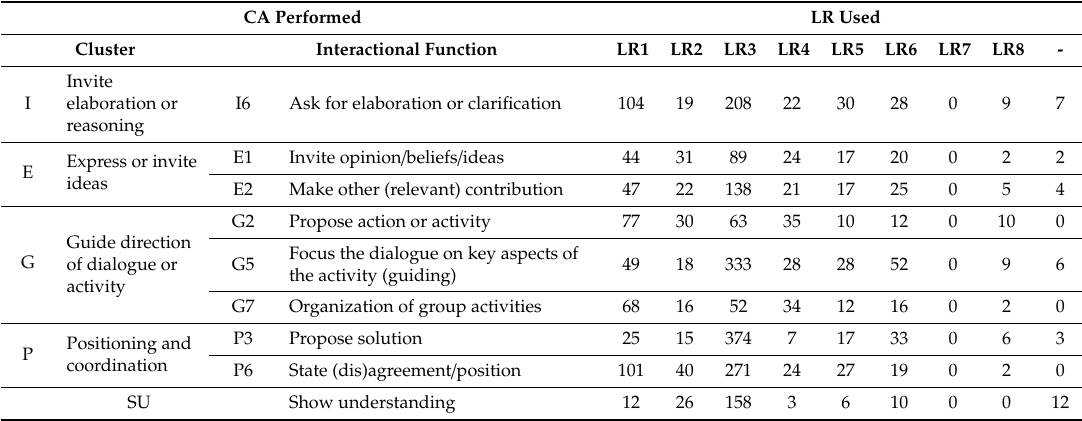
Table 3. Linguistic resources (LR) used in the most frequently performed